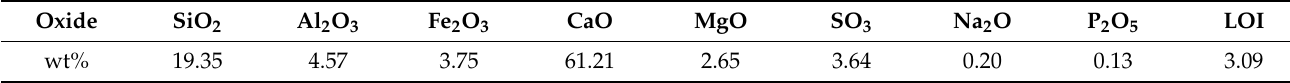
Table 1. Chemical composition of